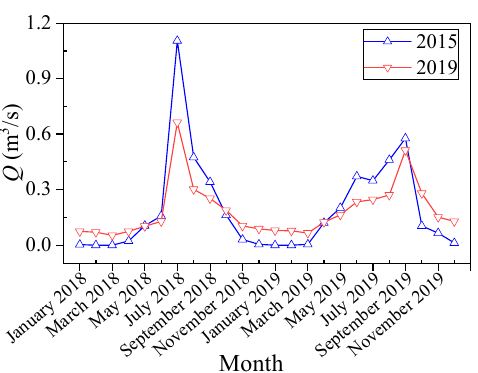
Figure 6. The simulated flow discharge at the downstream (outlet) point under the land use scenarios of 2015 and 2019.